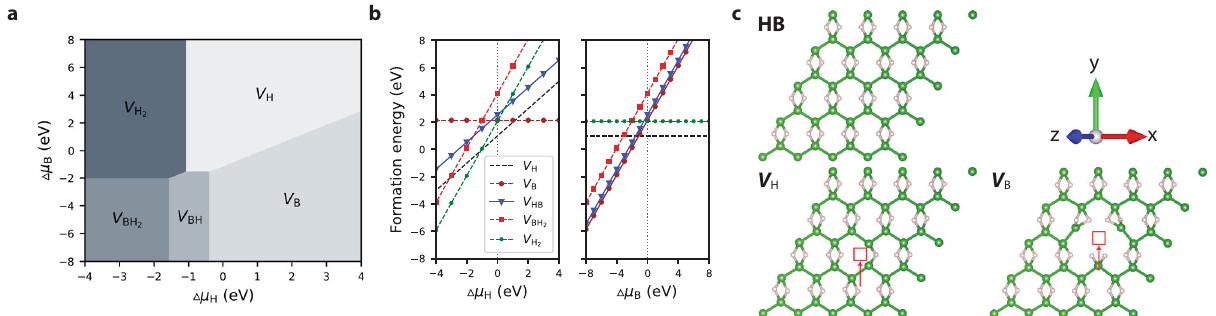
, Δ μ ) space. b Formation energy as a function of H B